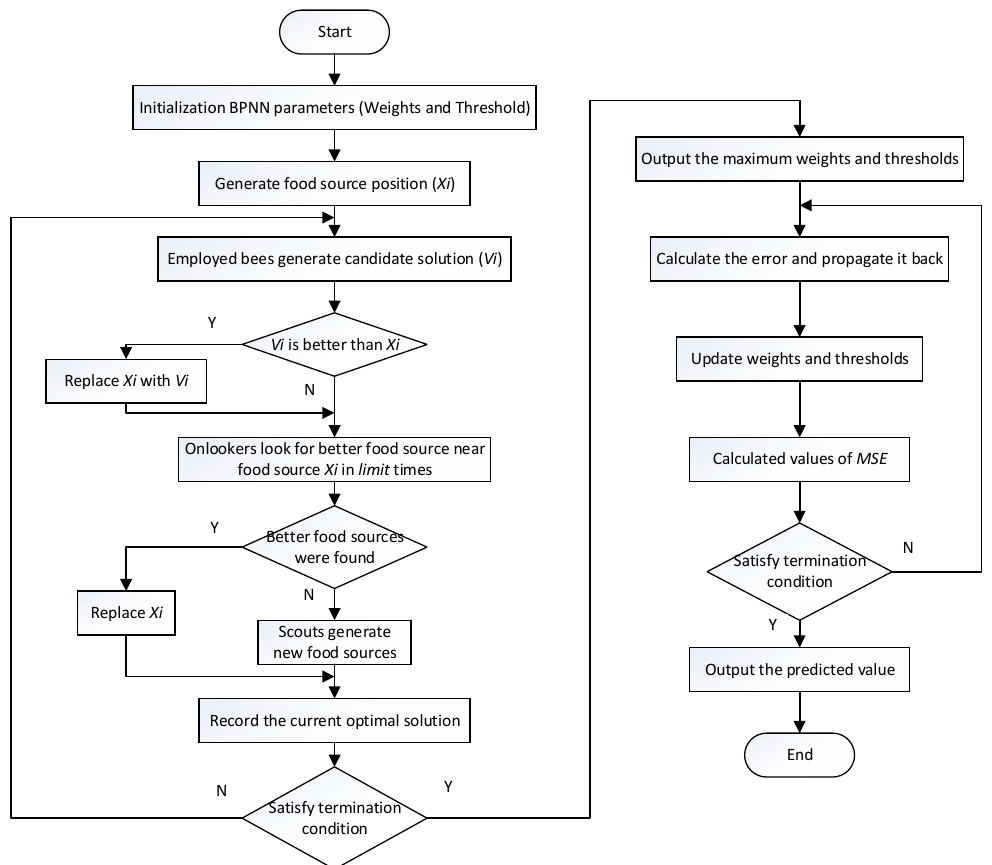
Figure 1. The flow chart of the ABC-BPNN algorithm.